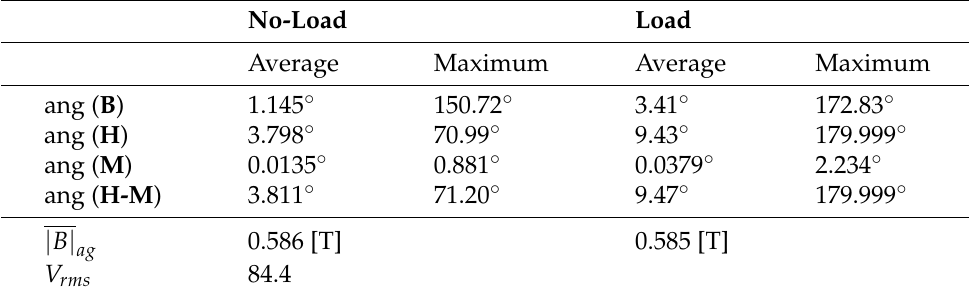
Table 3. The averaged and maximum angular dependency of magnetic flux density, B , magnetic field strength, H , and magnetization, M , for the default case of the rotating machine, denoted ang(). The averaged magnitudes of the air gap flux density for no-load and load, and the no load RMS voltage are also